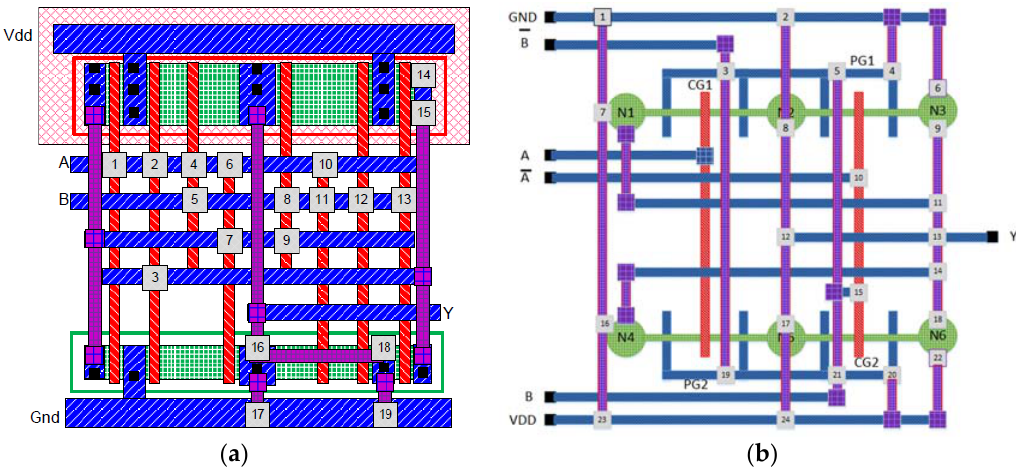
Figure 47. ( a ) Camouflage layout of CMOS logic gates Reproduced with permission from [119], Copyright ACM, 2013; ( b ) Camouflage layout of SiNW logic gates. Copyright ACM, 2013; ( b ) Camouflage layout of SiNW logic